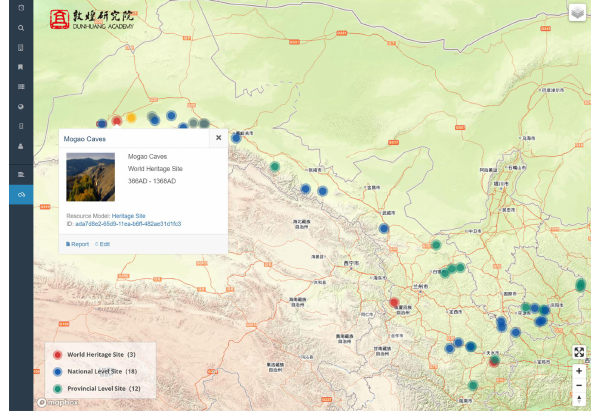
Figure 5. The grottoes basic data view Base Map Source: © Tianditu